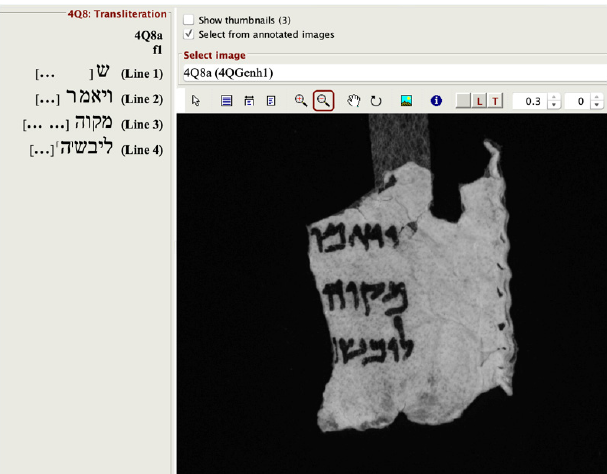
Figure 16: High-resolution digital image of a Dead Sea Scroll fragment (4Q8 a ) linked to its transcription; image used by permis- sion of the Israel Antiquities Authority